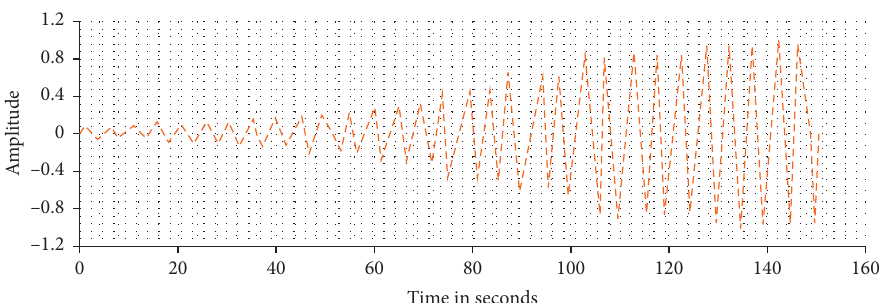
Figure 5: Amplitude time history to apply cyclic loading.